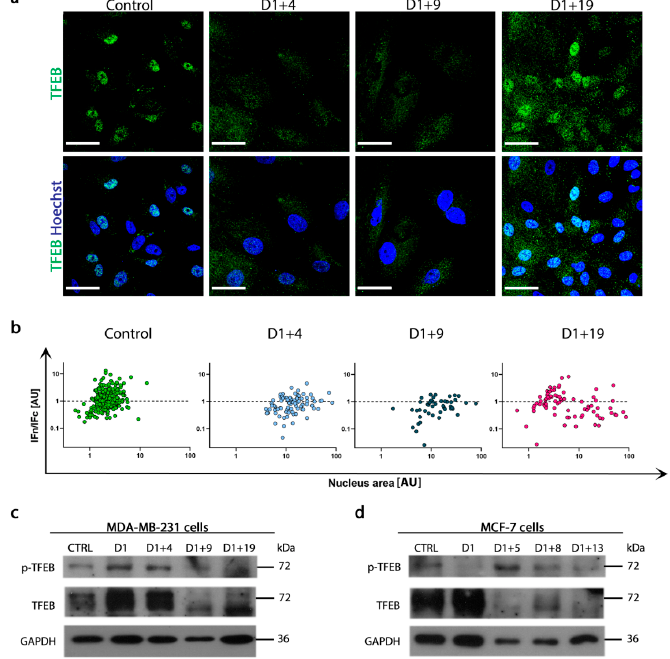
Figure 6. Transcription Factor EB (TFEB) translocation to the nucleus in escapers with functional autophagic flux. ( a ) Representative immunofluorescence images of TFEB (green) protein localization in MDA-MB-231 cells, nuclei stained with Hoechst (blue). Scale bar: 50 µ m. ( b ) Quantitative analysis of the intensity of TFEB fluorescence in nucleus / cytoplasm (IFn / IFc) versus nucleus area in MDA-MB-231 cells. ( c , d ) Representative western blots showing p-TFEB (S142) and TFEB protein levels in MDA-MB-231 ( c ) and MCF-7 cells ( d